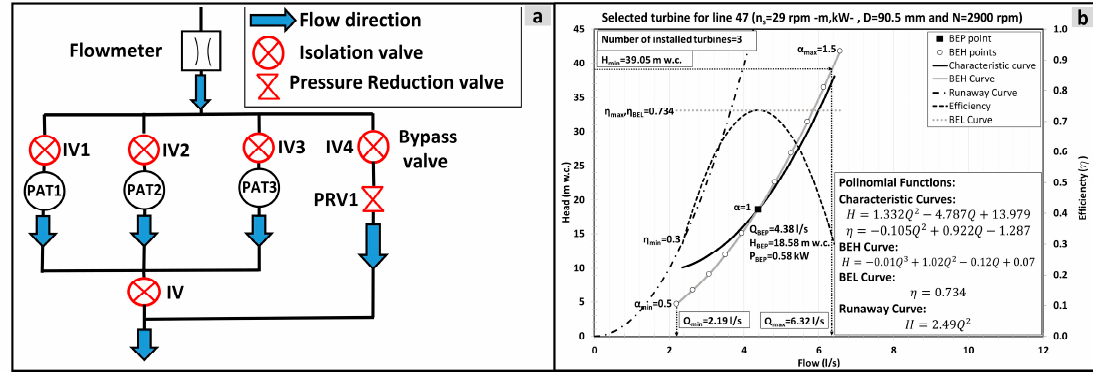
Figure 8. Operation scheme ( a ) and selected PAT ( b ).